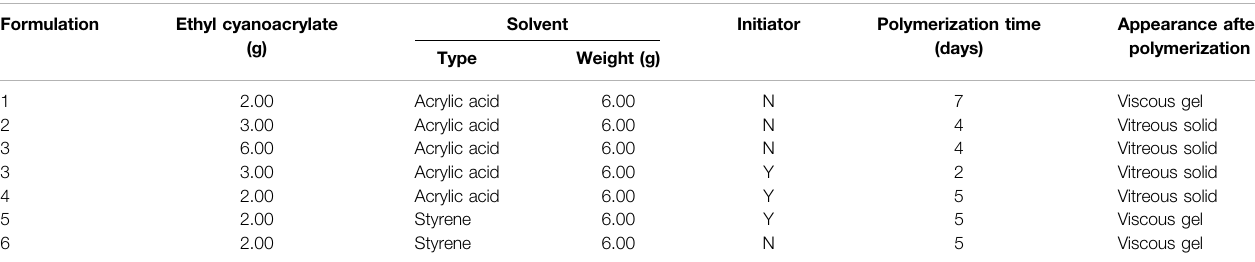
TABLE 2 | Polymerization time and aspect of different formulations.